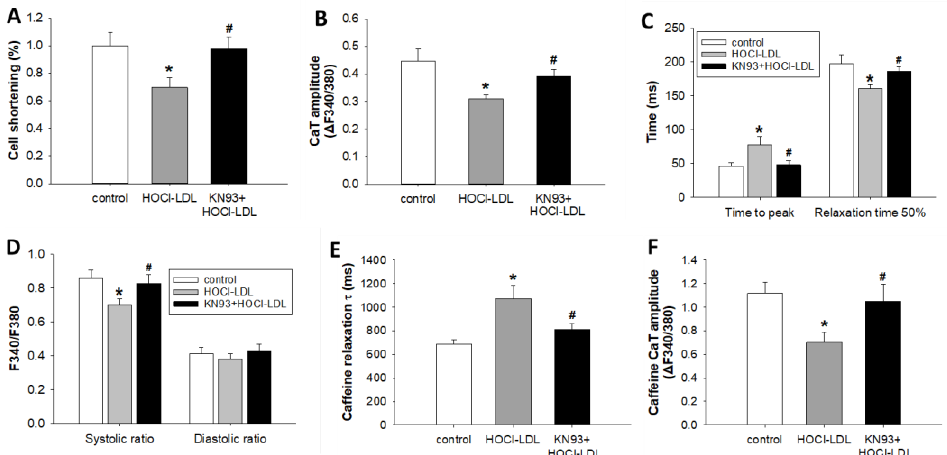
Figure 4. HOCl-LDL-induced CaMKII oxidation modulates cardiomyocyte contractility and Ca 2+ homeostasis. GPV cardiomyocytes were incubated with HOCl-LDL (oxidant:lipoprotein molar ratio of 200:1, 250 µg/mL, 14 h) in the absence or presence of KN93 (5 µM, added 30 min prior to HOCl-LDL). ( A ) Cell shortening, ( B ) CaT amplitude, ( C ) time to peak and relaxation time (50%), ( D ) CaT systolic and diastolic ratio, ( E ) Caffeine-induced CaT decay τ , and ( F ) Caffeine-induced CaT amplitude were analyzed for cardiomyocytes stimulated at ( A – D ) 1 Hz or ( E , F ) unstimulated ( n = 22). Values are expressed as mean ± SEM. ( n ) represents the number of cardiomyocytes. * indicates p < 0.05 vs. control, # indicates p < 0.05 vs. HOCl-LDL.